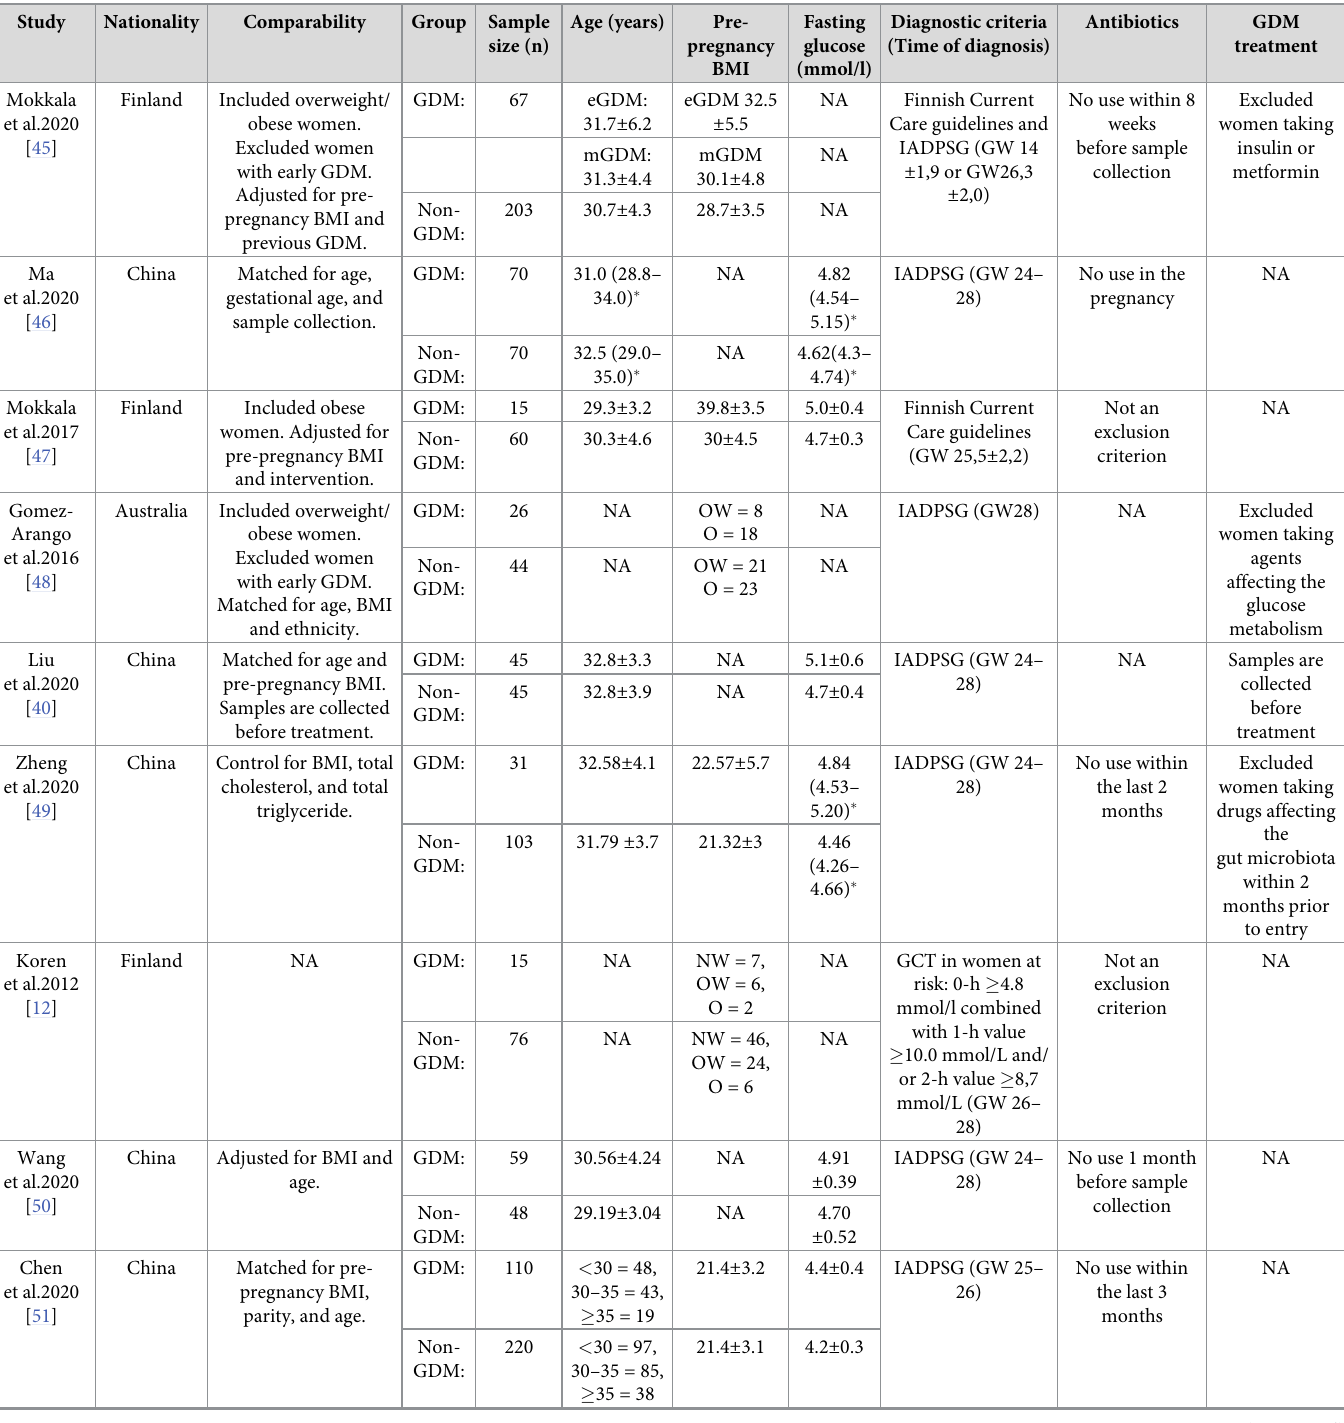
Table 1. Demographic and clinical characteristics of the included